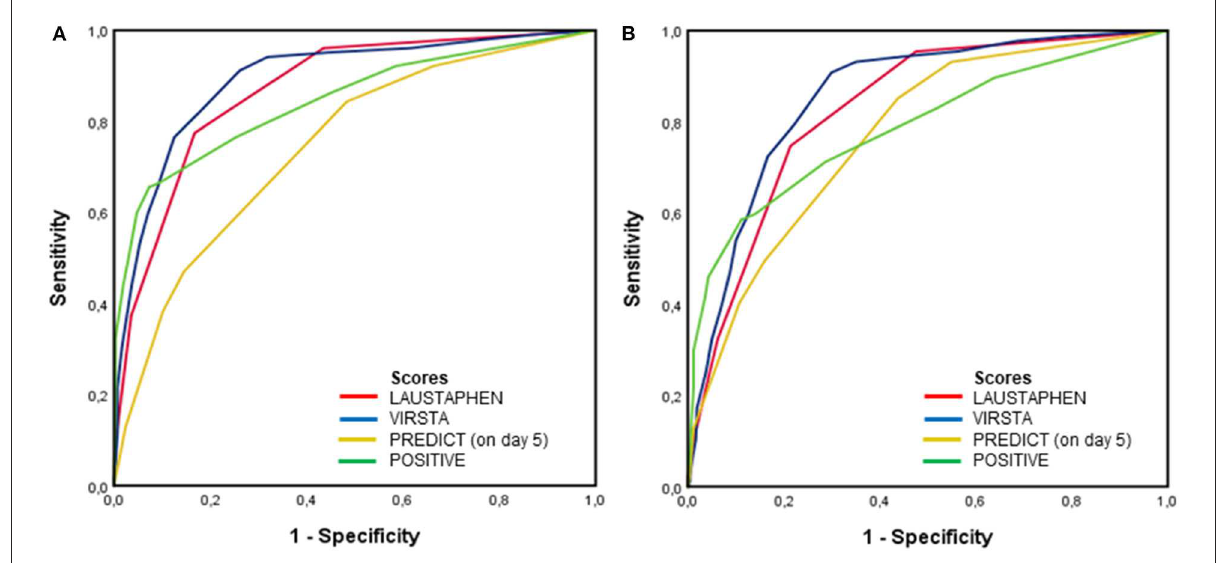
FIGURE1 ROC of PREDICT, VIRSTA, POSITIVE, and LAUSTAPHEN scores in predicting (A) definite IE in the whole population and (B) cardiac lesion in patients who had an echocardiogram, cardiac surgery, or